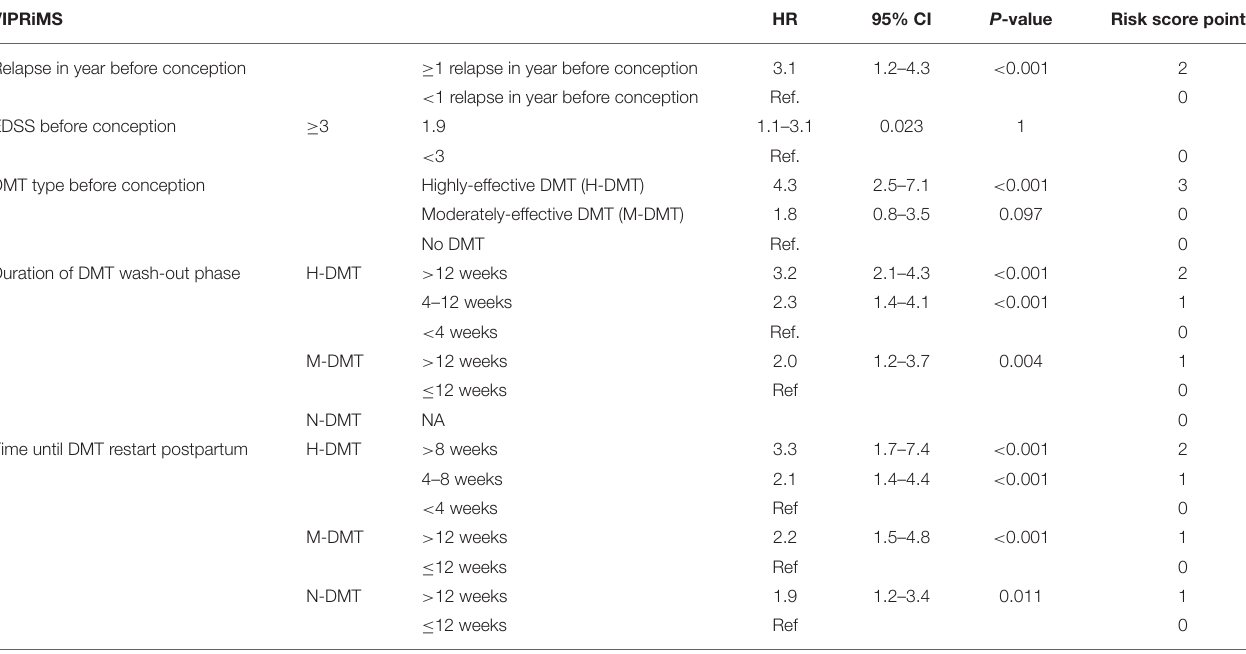
TABLE 2 | Variables predicting occurrence of clinical disease reactivation in pregnancy and postpartum in the generation cohort.